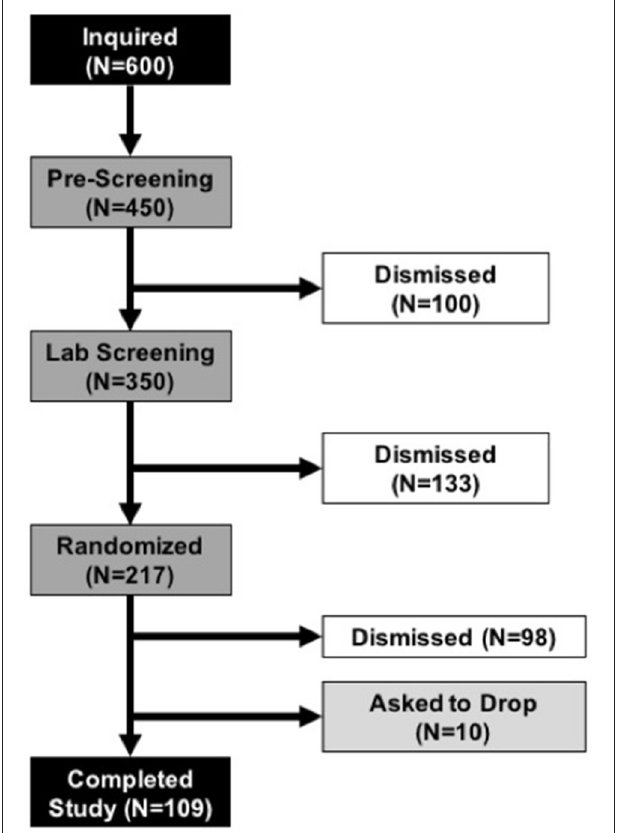
FIGURE 2 | Consort Diagram. Demonstrates subject progression through the various phases of the study from initial inquiry (top black box) to completion of all study tasks (bottom black bar). During the Pre-Screening and Lab Screening phases subjects who did not meet the study requirements were dismissed from further participation. Once subjects were randomized, the most common reasons that subjects were dismissed was for failure to follow the study protocol (i.e., irregular consumption of supplement) or missed study appointments. No subjects dropped or were dismissed due to adverse reactions to the supplement or study